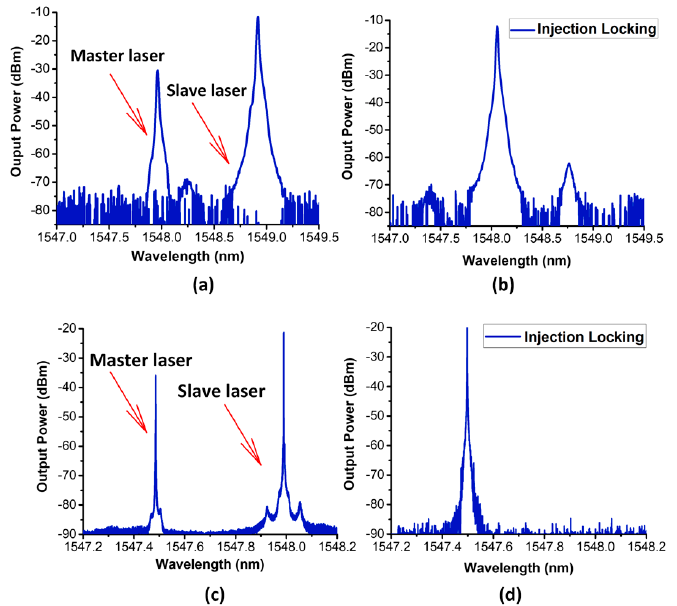
Figure 2. ( a ) Continuous-wave (CW) spectrum of the master (biased at 35 mA) and slave (biased